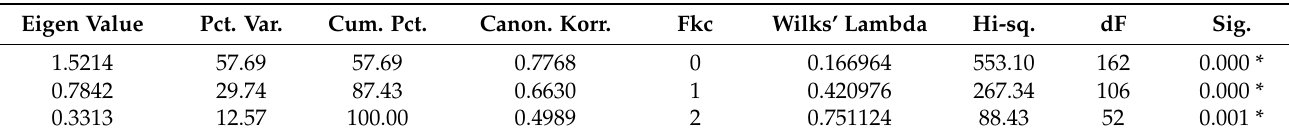
Table 1. Canonical discriminant functions.